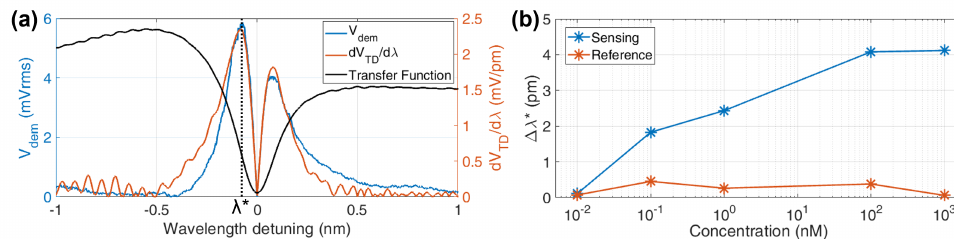
Figure 6. Opto − Magnetic measurements and results. ( a ) Typical acquired curves: the MRR transfer function as V TD intensity (no scale), its derivative absolute value which superimposes to the second harmonics V dem . ( b ) Resonance shift dependence on the target solution concentration from 10p M to 1µ M